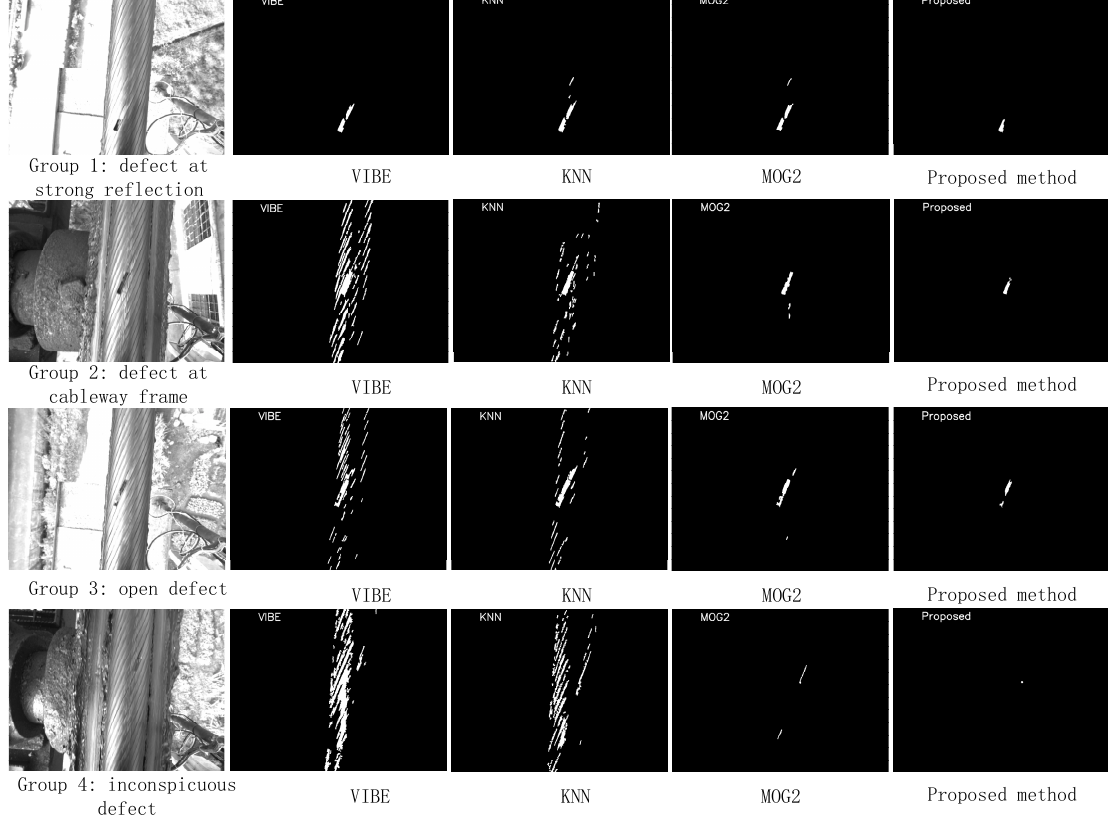
Figure 13. Detection effects of VIBE, KNN, and MOG2 and the proposed method for fracture. Table 1. FAR statistical results of VIBE, KNN, and MOG2 and the proposed method at different groups.